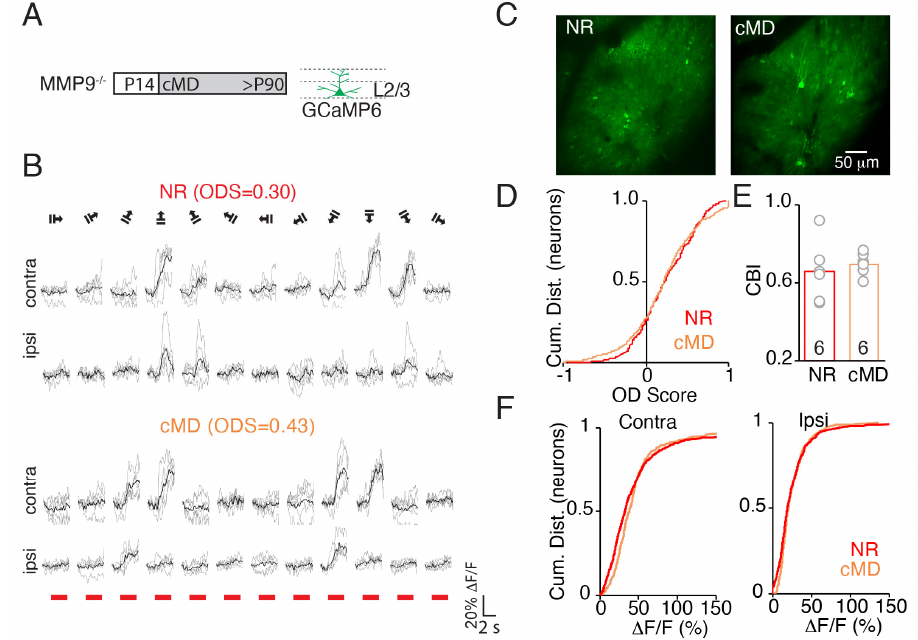
Figure 2. Ocular dominance in MMP9 − / − mice is normal and resistant to cMD. ( A ) Left: Experimental timeline. Right: GCaMP6s expression was targeted to layer 2/3 neurons of MMP9 − / − V1b. ( B ) Representative Δ F/F of GCaMP6 signal evoked in layer 2/3 of V1b in normal reared (NR) and cMD MMP9 − / − mice in response to presentation of drifting square wave gratings (0.05 cycle/degree, 1 Hz, 100% contrast, 28 cd/m 2 at 12 orientations) to contra ‐ and ipsilateral eyes. Red bar = stimulus onset. Individual trials in grey, average of 5 repeats in black. Ocular dominance score (OD score) = (C ‐ I)/(C + I) was calculated at the preferred orientation for each neuron. ( C ) Examples of two ‐ photon field views of GCaMP6s expres ‐ sion. ( D ) Cumulative distribution of ODS ( p = 0.42, KS test). ( E ) Mean CBI of layer 2/3 neurons is similar in cMD and NR MMP9 − / − mice. p = 0.38, Mann − Whitney test. n = 6 subjects. ( F ) Cumulative distribution of contra and ipsi eye visual re ‐ sponses ( Δ F/F; p = 0.75 for contra, p = 0.63 for ipsi, Student’s t ‐ test, 328 and 595 neurons for NR and cMD, respectively).